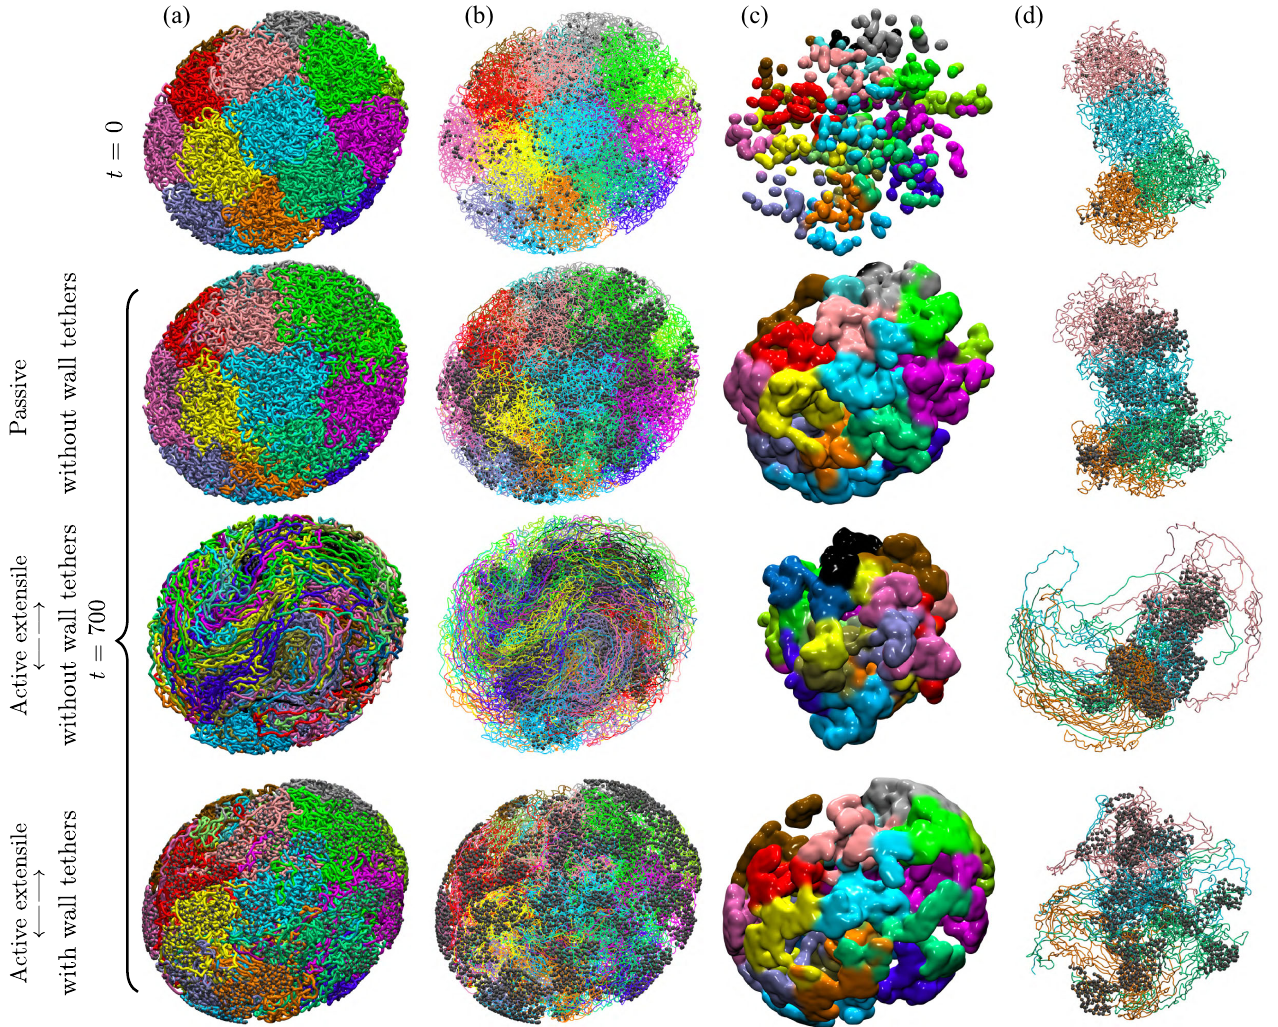
FIG. 2. Longtime evolution of chromatin in simulations of three systems, one with passive euchromatin ( σ 0 ¼ 0 ) and two with active euchromatin (extensile, σ 0 ¼ 30 ). In the first two, chromatin-lamin interactions are absent, but they are included in the third one. Top row: initial system configuration at t ¼ 0 , which is identical in all simulations; second, third, and fourth rows: system configurations at dimensionless time t ¼ 700 . The four columns show, from left to right, (a) the full chromatin system, with colors corresponding to distinct chromosomes; (b) the cross-links within and between HC blocks, shown as gray beads and overlayed on top of the chains; (c) the location of HC regions (HCRs), defined as regions in space where the cross-link density exceeds 50% of its maximum measured value in the simulations, and colored by chain membership; and (d) a subset of four chromosomes and associated cross-links. Also, see videos of the dynamics in the Supplemental Material